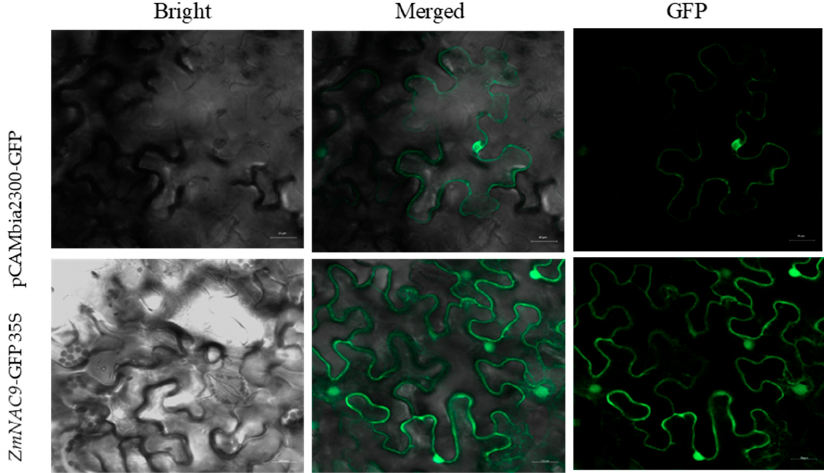
Figure 9. Subcellular localization of ZmNAC9 –green fluorescence protein (GFP) green fusion protein in the tobacco (Nicotiana benthamiana) epidermal cells of leaf.